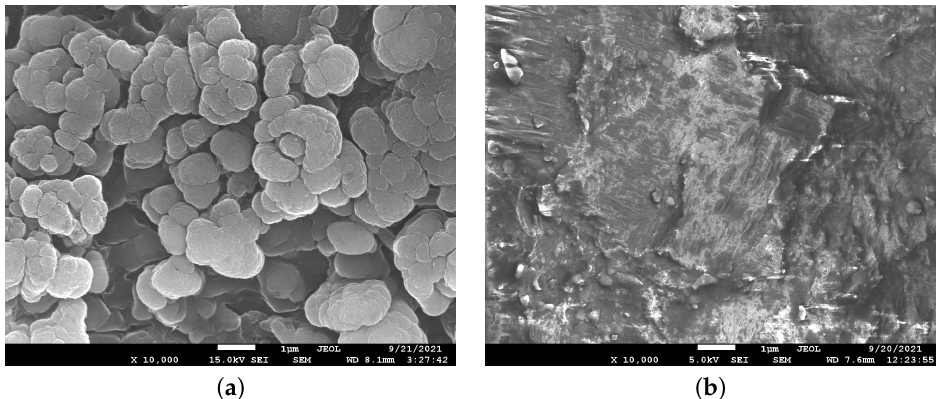
Figure 1. Scanning electron microscope images of the surface of a CVD diamond sample after laser cut ( a ) and after laser polishing ( b ).